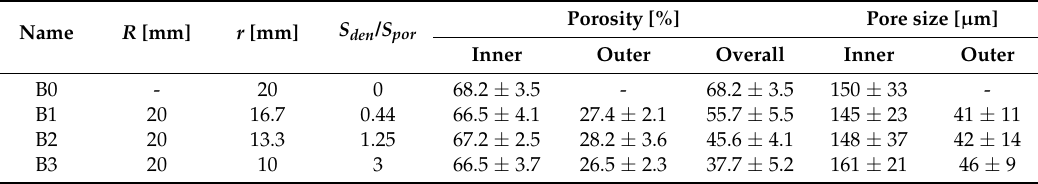
Table 1. Pore characteristics of porous HA scaffolds with bone-like structures.